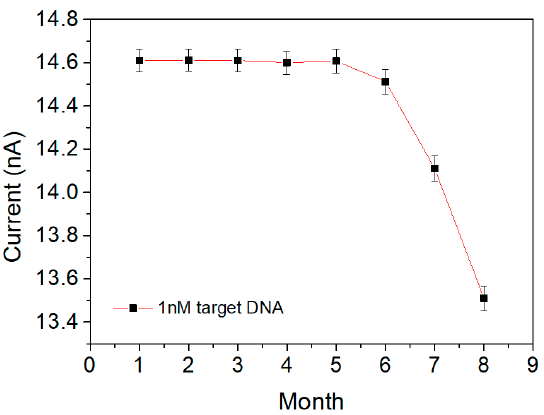
Figure 8. Current responses of an IDE sensor for 1 nM target DNA measured for 8 months.